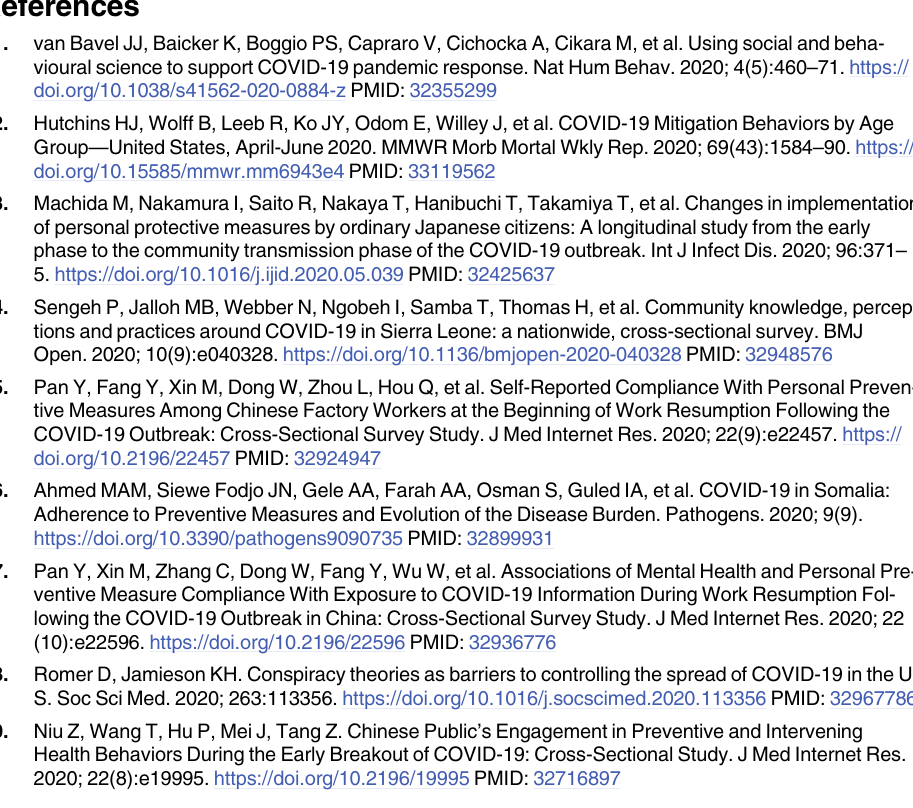
S7 Table. Prevalence ratios (95% confidence intervals) of recommended preventive behav- iors or alerting others according to the COVID-19 information sources with adjustment for fear and